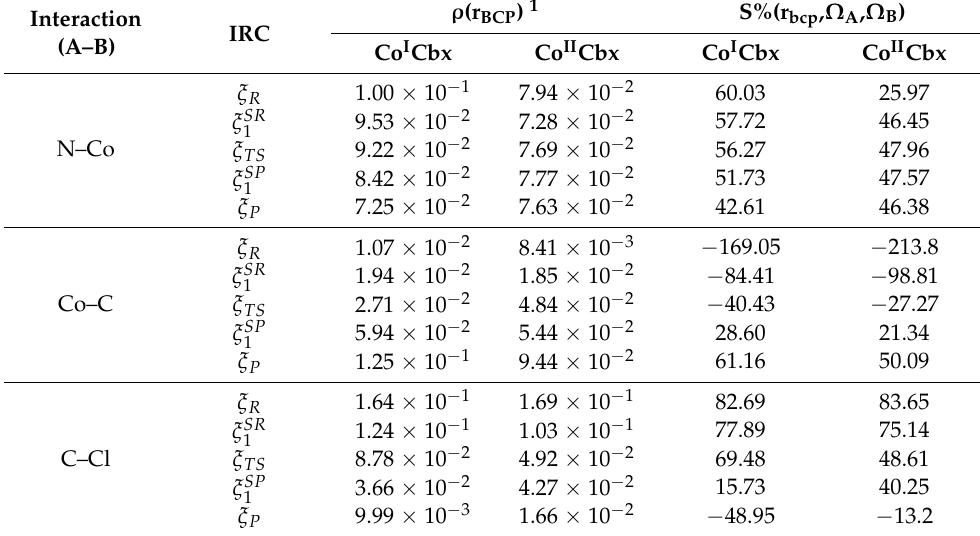
Table 2. Source function description at the N–Co, Co–C, and C–Cl BCPs interactions measured in the IRC points ξ R , ξ SR , ξ TS , ξ SP , and ξ P for the dehalogenation of chloromethane mediated by Co I Cbx. 1 1